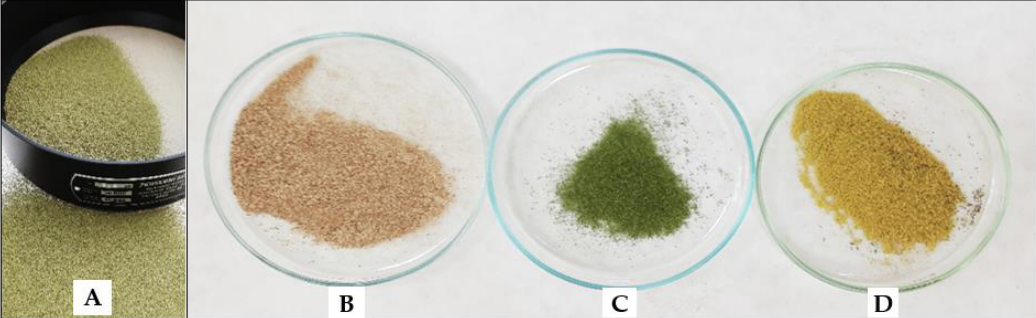
Figure 2. Pharmacopoeial sieve ( A ) and powdered samples of K. panniculata , stem bark ( B ), leaves ( A , C ), and flowers with flower buds ( D ).